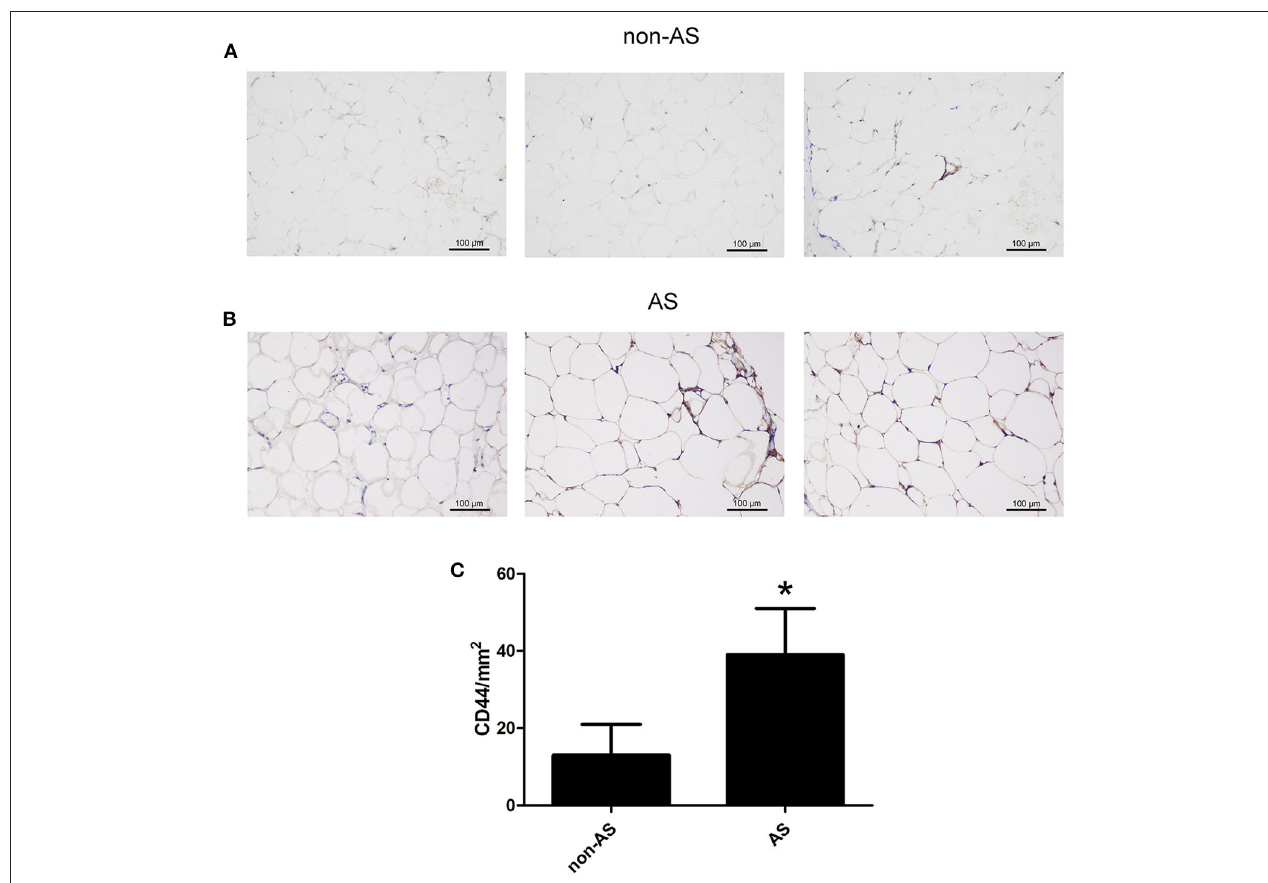
FIGURE 1 | The expression of CD44 in EAT of CAHD or non-CAHD patients. (A) The expression level of CD44 in EAT of non-CAHD patients. (B) The expression level of CD44 in EAT of CAHD patients. (C) The comparison of the number of CD44 positive cells in EAT of CAHD or non-CAHD patients. non-AS: the EAT of non-CAHD patients. AS: the EAT of CAHD patients. * P < 0.05 vs. non-AS.